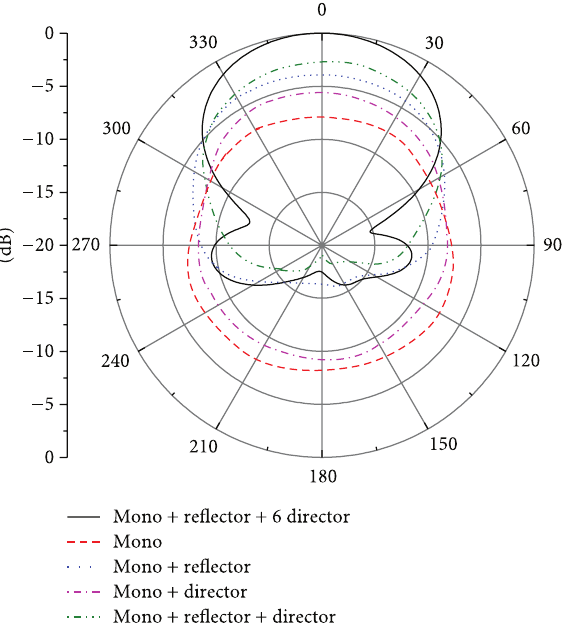
Figure 2: Radiation patterns of microstrip monopole only, mi- crostrip monopole and a reflector, microstrip monopole and a director, microstrip monopole and a reflector with one director, and microstrip monopole and a reflector with six director. Table 1: The measured VSWR of the quasi-Yagi antenna. No.